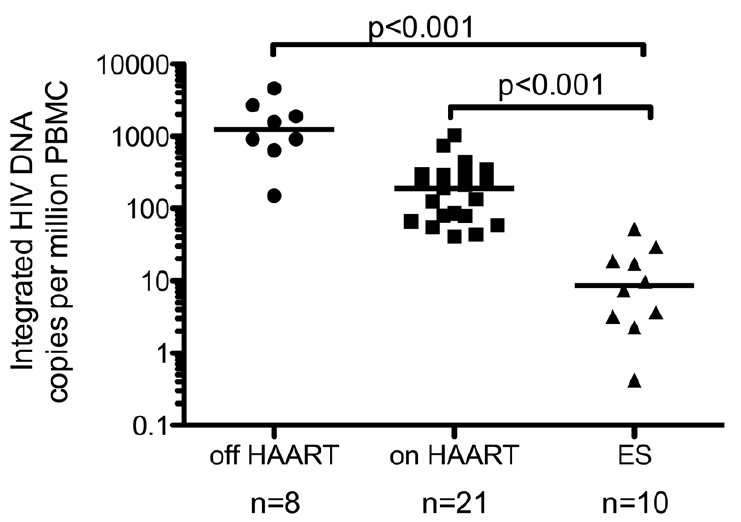
Figure 2. Elite suppressors have lower levels of integration than other HIV + patients on and off HAART. HIV DNA Integration levels from ten ES patients were compared to the levels found in 21 patients on and 8 patients off HAART. Individual levels of total and integrated HIV DNA have been previously published for 10 of the patients on and 6 of the patients off HAART [21,22]. The level of integration in ES patients was significantly lower than patients off and on HAART. The level in the on HAART group was also statistically lower than off HAART (p , 0.001, statistical test described in methods). The line represents the median value.